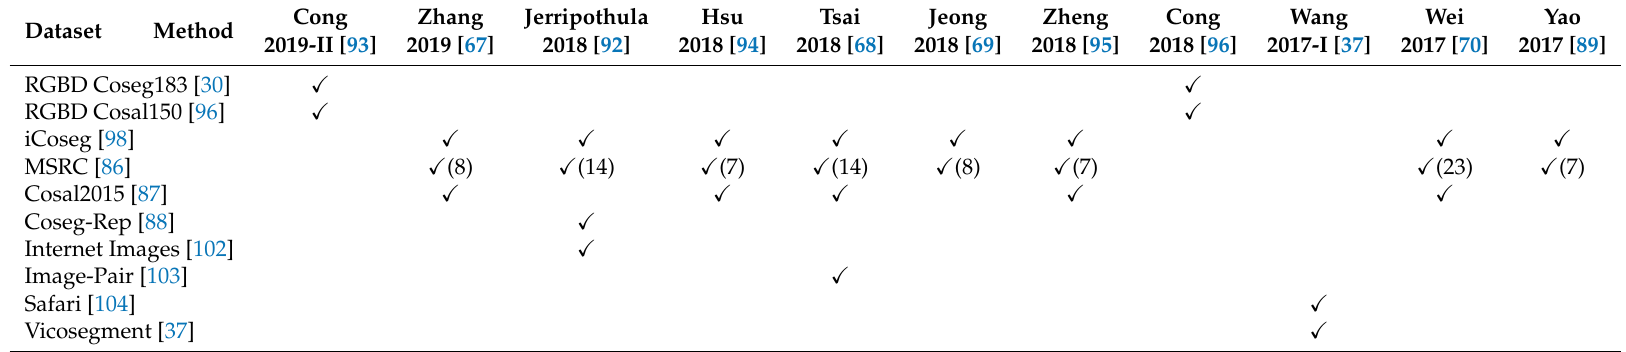
Table 6. Dataset/method matrix for co-saliency estimation. The number in parentheses indicates the version of the MSRC dataset identified by the number of image groups.